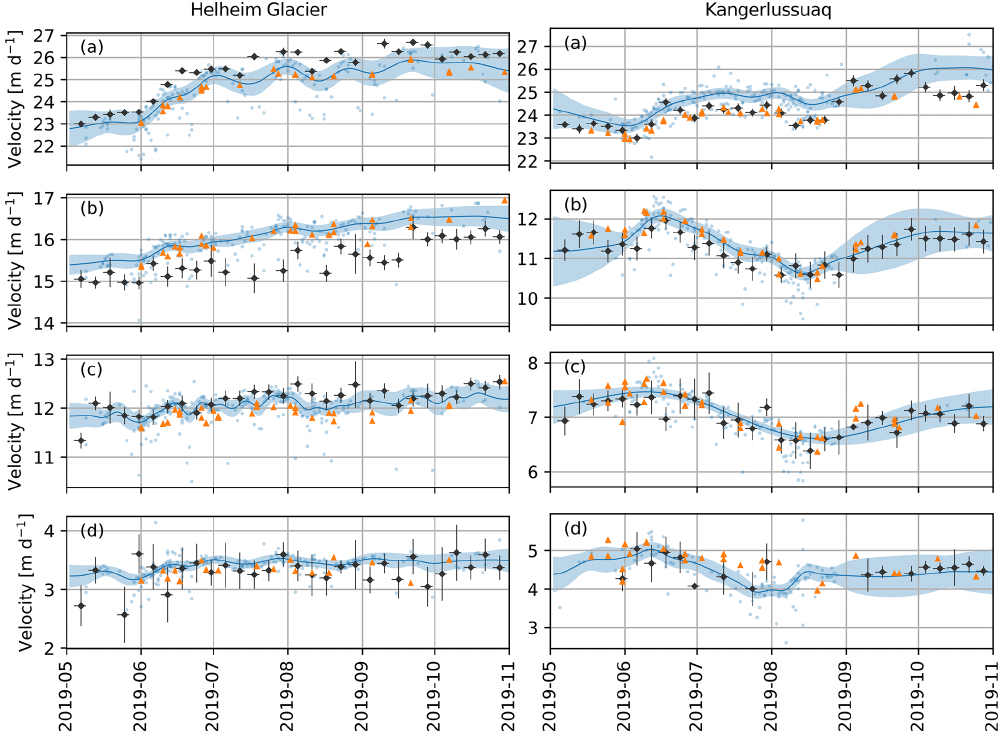
Figure 7. Corrected Sentinel-2 (blue dots), ITS_LIVE Landsat-8 (orange triangles), and MEaSUREs Sentinel-1 (black diamonds) velocity time series for four sample glaciers in 2019. Top to bottom are points (a–d) in Fig. 1. The blue line marks the output of the Gaussian process regression, with the blue shading marking the 2 σ uncertainty